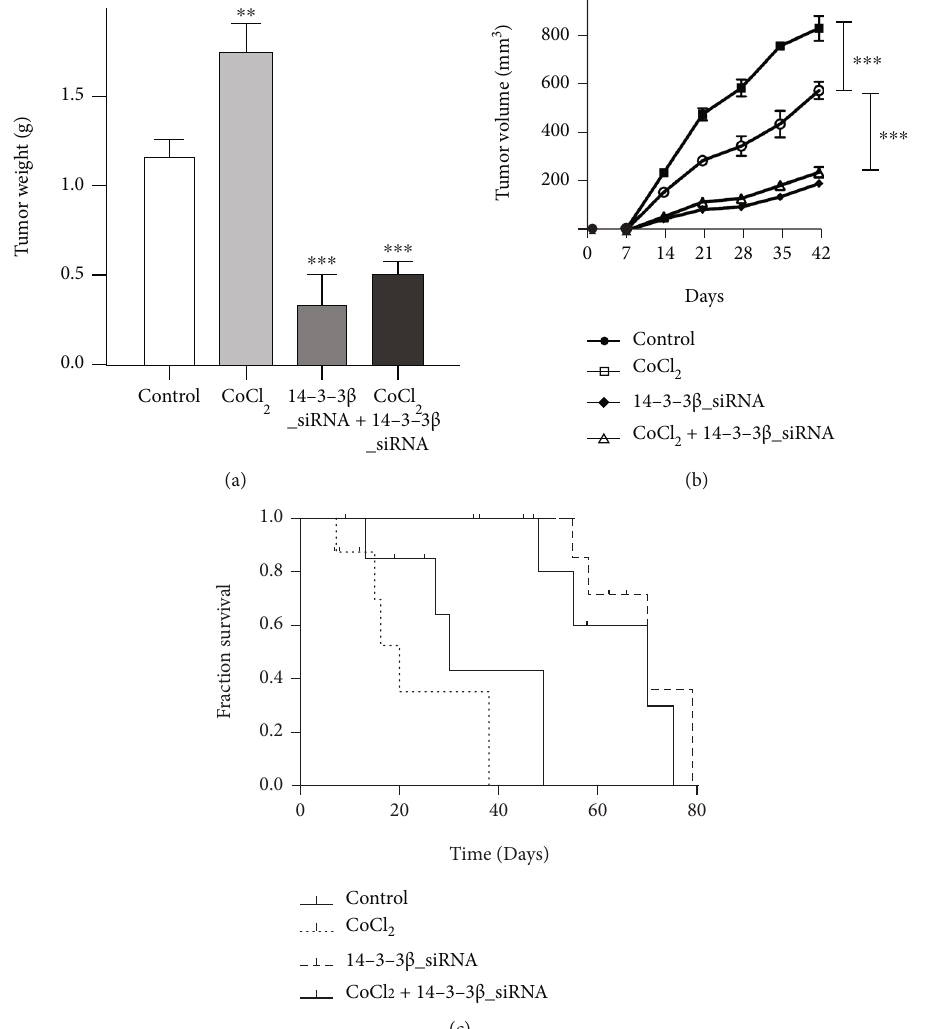
Figure 3: E ff ects of 14-3-3 β knockdown on subcutaneous tumor growth. (a) E ff ect of CoCl tumor weight in a tumor xenograft model (CoCl vs. control, P < 0 : 01 ; 14-3-3 β siRNA vs. control, P < 0 : 001 ; CoCl 2 , P < 0 : 001 ). (b) E ff ect of CoCl application and 14-3-3 β siRNA transfection on tumor volume in a tumor xenograft model CoCl 2 2